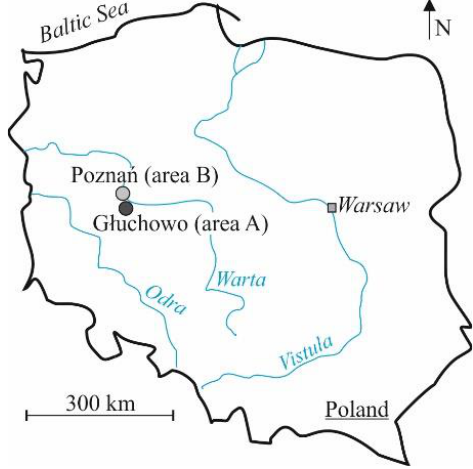
Figure 3. Location of research sites.